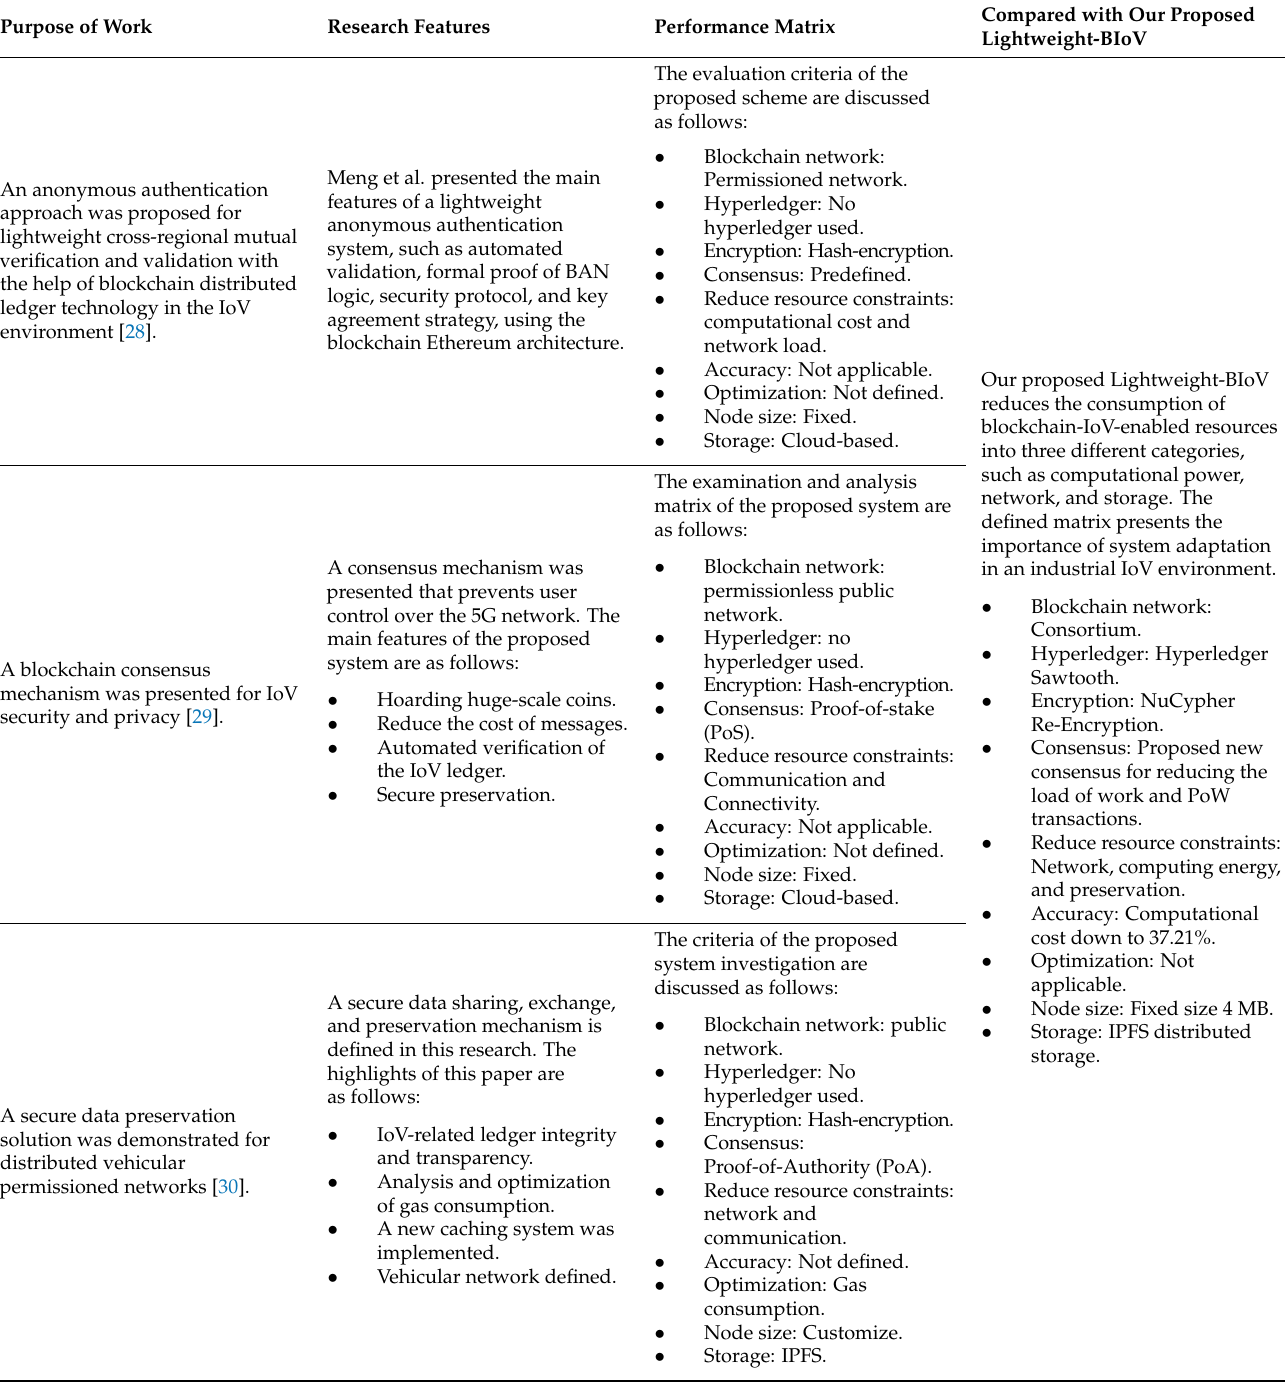
Table 2. Comparison of The Proposed Lightweight-BIoV with Other